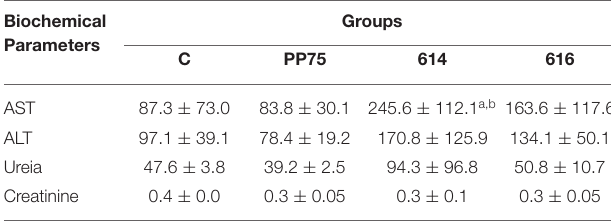
FIGURE 2 | Survival curve of hamsters analyzed in control (C: ) group and experimentally L. infantum -infected groups (wild strains: 614, and 616, ; reference strain: PP75, ). The data were displayed as descriptive analyses given they are representative of each strain. All the groups were analyzed during 210 days after infection and euthanasia was performed for necropsy evaluation.